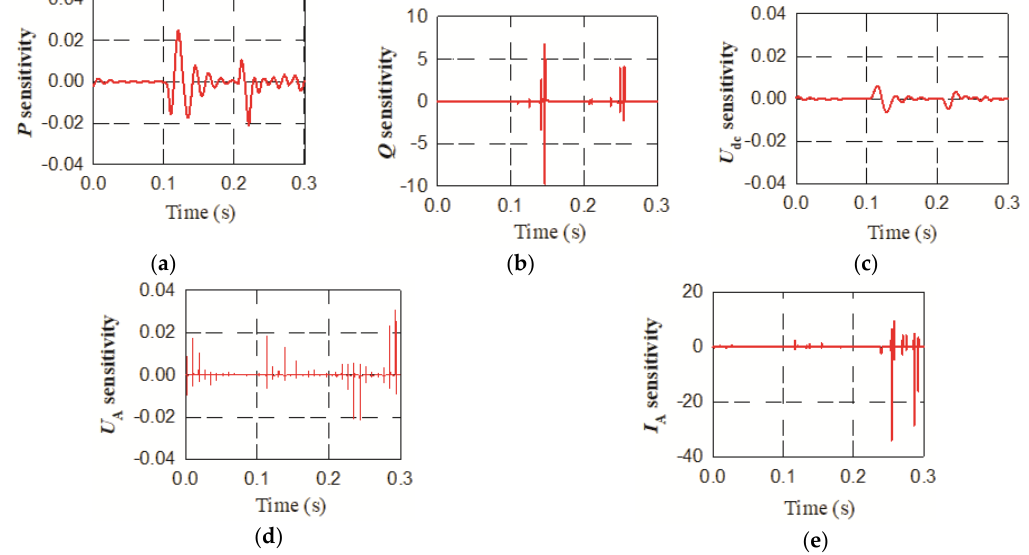
Figure 9. Trajectories sensitivity of notch filter parameters: ( a ) Active power sensitivity; ( b ) Reactive power sensitivity; ( c ) DC bus voltage sensitivity; ( d ) Phase A voltage sensitivity; ( e ) Phase A current sensitivity;